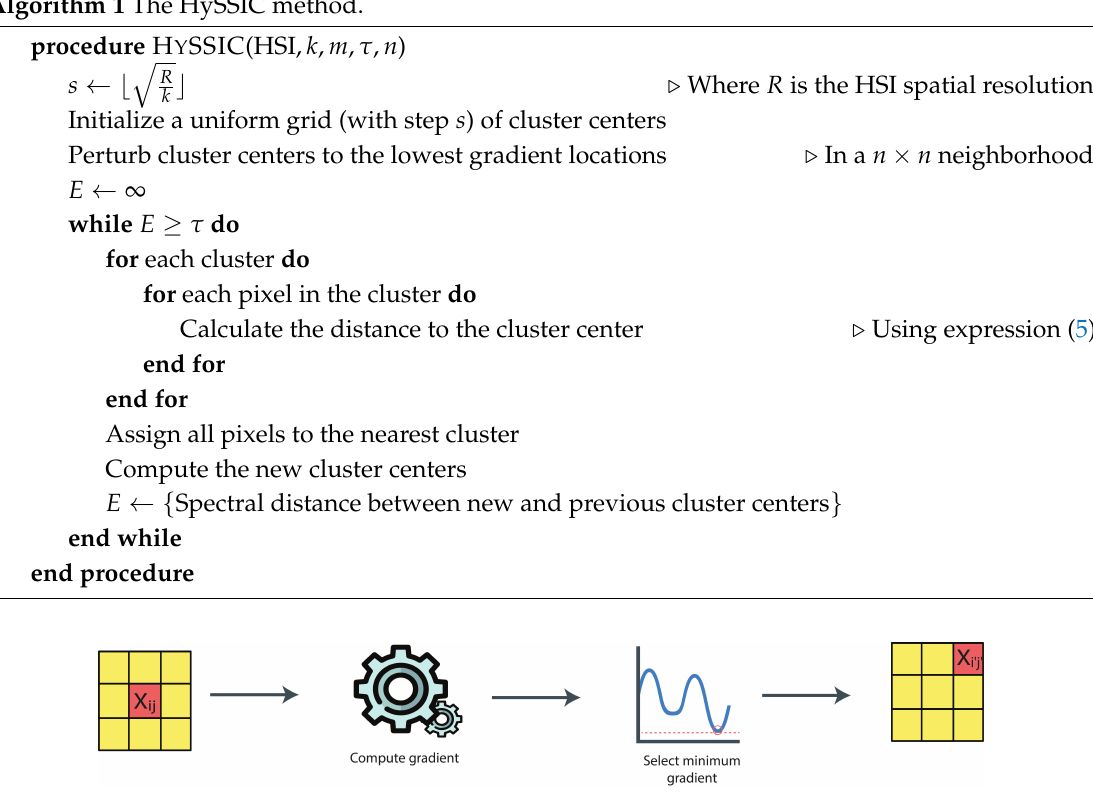
Figure 6. Procedure of the minimum gradient reallocation of a single centroid using 3 × 3 neighborhood hyper spectral